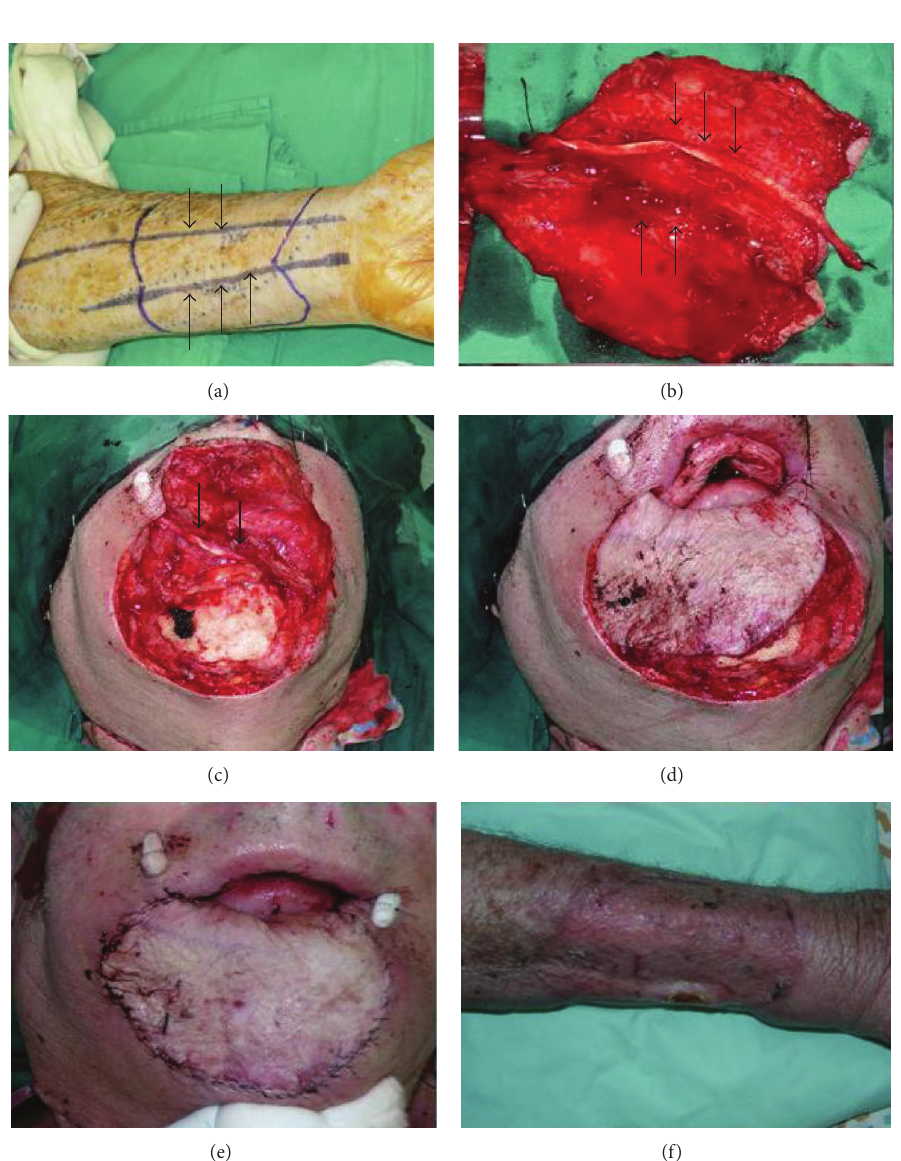
Figure 1: Surgical technique. (a) Marking of radial artery (two arrows) and palmaris longus tendon (three arrows), (b) Flap elevated showing vascular pedicle (thin arrows) and palmaris longus tendon (thick arrows) attached to the under surface of the flap by thin peritendon. (c) Part of the flap is sutured to the oral mucosa for lining and the tendon (Arrows) is secured to the Modioulus, Buccinator muscle. (d) The skin paddle is folded over the tendon (e) and suturing it in place. (f) Donor site is covered with split thickness skin